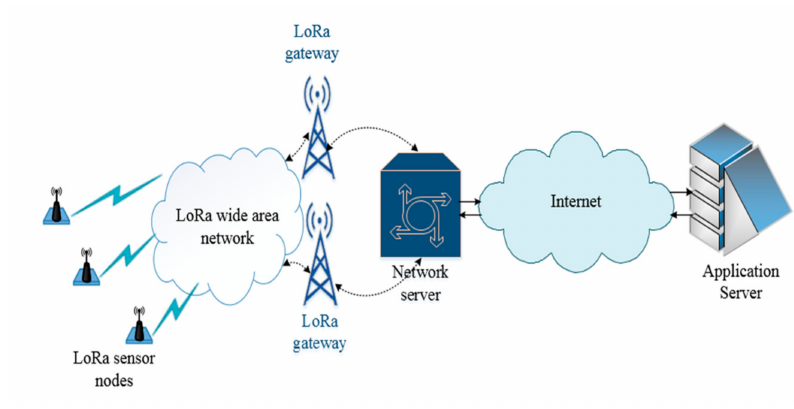
Figure 1. LoRaWAN network